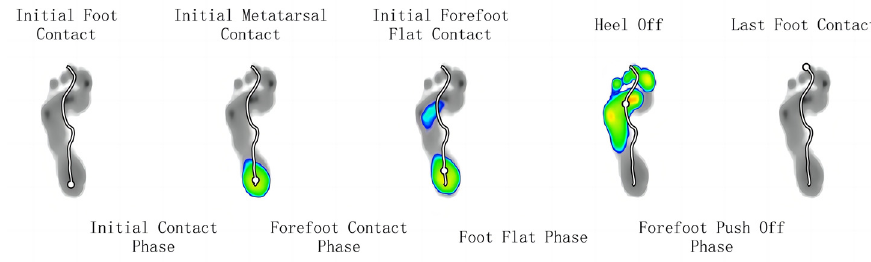
Figure 2. Segmentation of single foot timing.